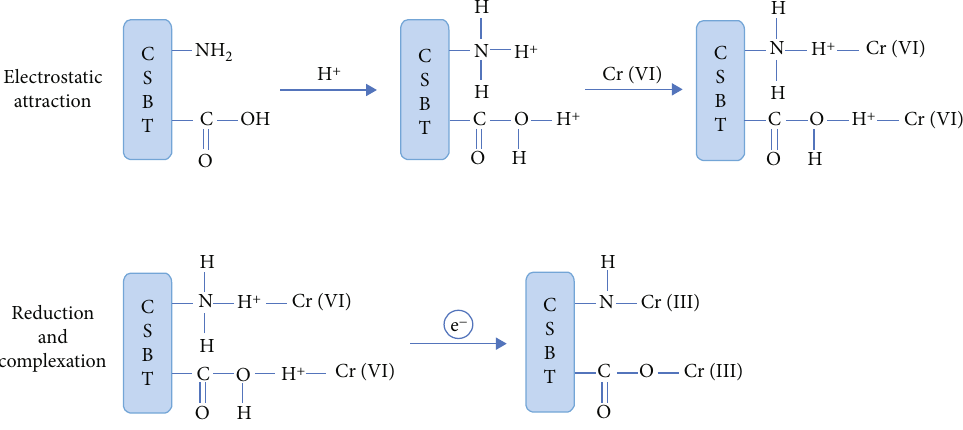
Figure 15: The adsorption mechanism of CSBT on Cr (VI).